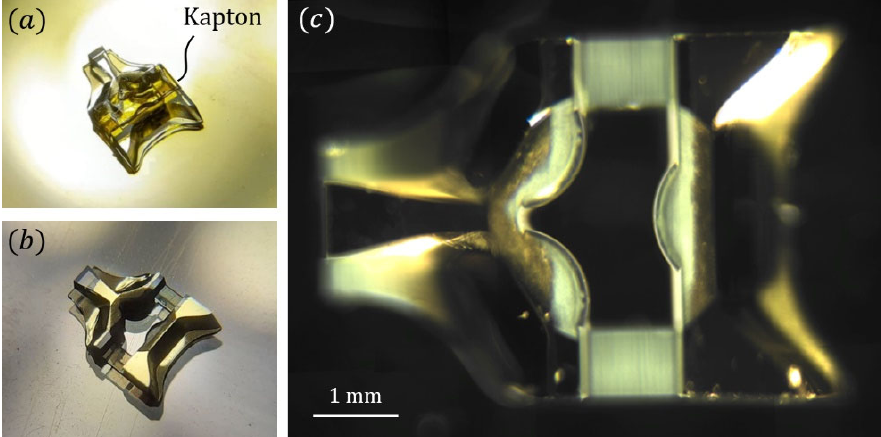
Figure 13. ( a ) Photography of the optical piece with the Kapton stencil. ( b ) Optical piece after the metallization process and stencil removal. ( c ) Optical top ‐ view of the final optical